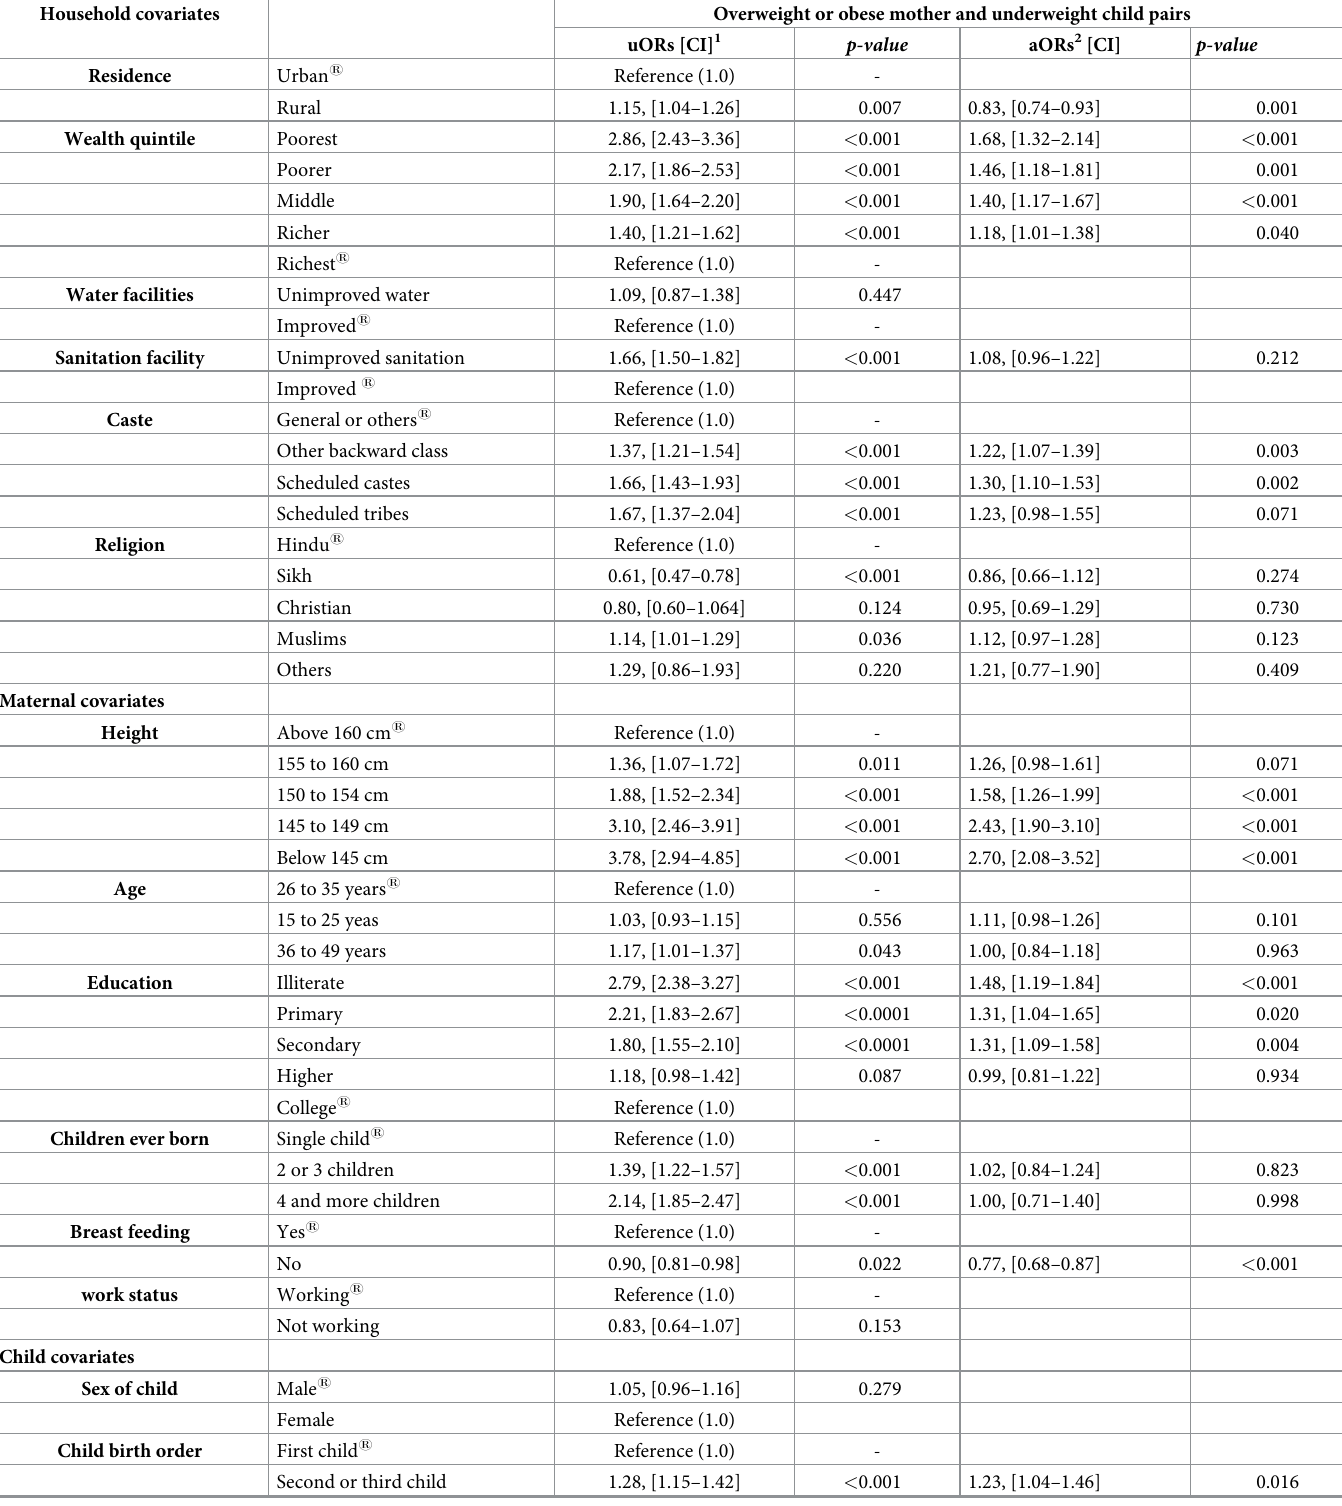
Table 3. Logistic regression results of overweight or obese mother and underweight child by familial, maternal, and child covariates. Household